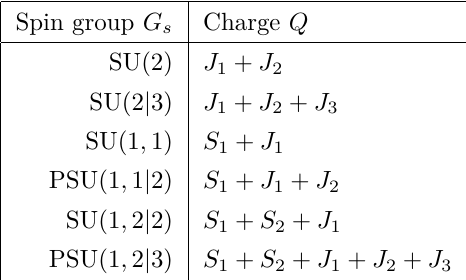
Table 1 . Spin groups G s for the SMTs obtained from the integer BPS bounds E ≥ Q